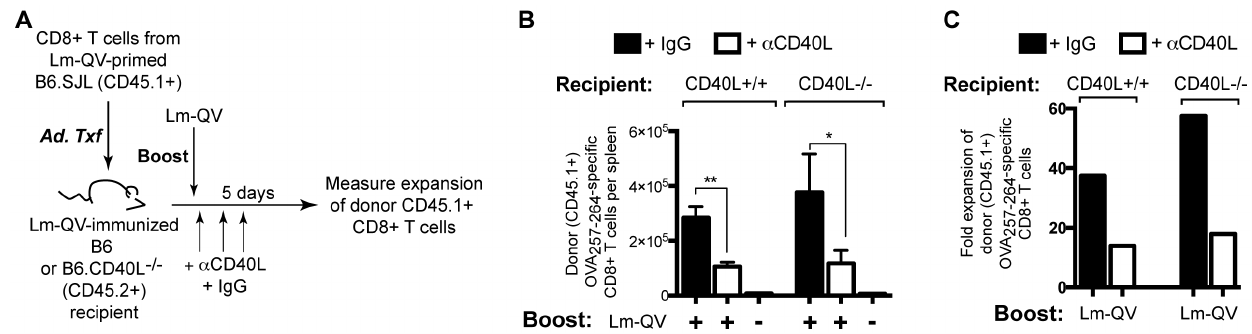
Figure 5. CD40L expressing mCD8 + T cells promote secondary expansion following homologous boost. (A) Experimental design: Donor (B6.SJL) mice and recipient (C57BL/6 and CD40L-deficient) mice were concurrently primed with 10 7 cfu Lm-QV. 21 days later, CD8 + T cells were purified from B6.SJL spleens and transferred into B6 and B6. Cd40L -/- mice. 24 h post-transfer, recipients were boosted with 5 6 10 6 cfu Lm-QV in the presence of a CD40L or control antibody. OVA 257–264 -specific memory CD8 + T cell responses were assessed 5 days following boost using intracellular cytokine staining for IFN- c ( n =5). (B) Total OVA 257–264 -specific (IFN- c + ) CD45.1 + CD8 + T cells per animal (mean, 6 SEM). *, P , 0.05, **, P , 0.01, Mann- Whitney. (C) Fold expansion of donor CD45.1 + IFN- c + OVA 257–264 -specific CD8 + T cells. Data are representative of three independent experiments.